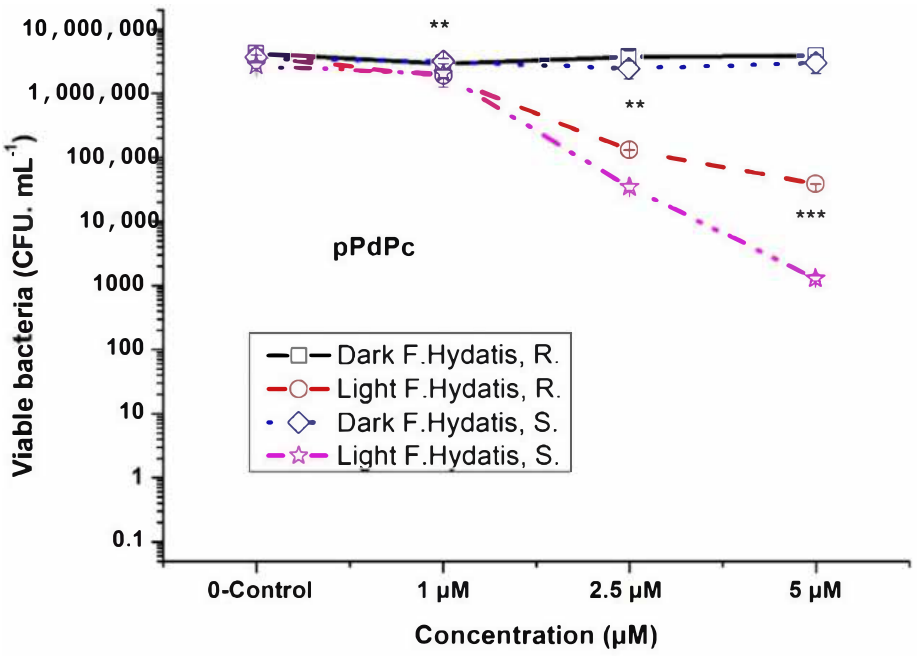
Figure 3. Photodynamic inactivation of F. hydatis (R and S) planktonic cultured with peripheral Pd(II)–phthalocyanine (pPdPc) and LED 665 nm irradiation. ** p < 0.008 and *** p < 0.01.